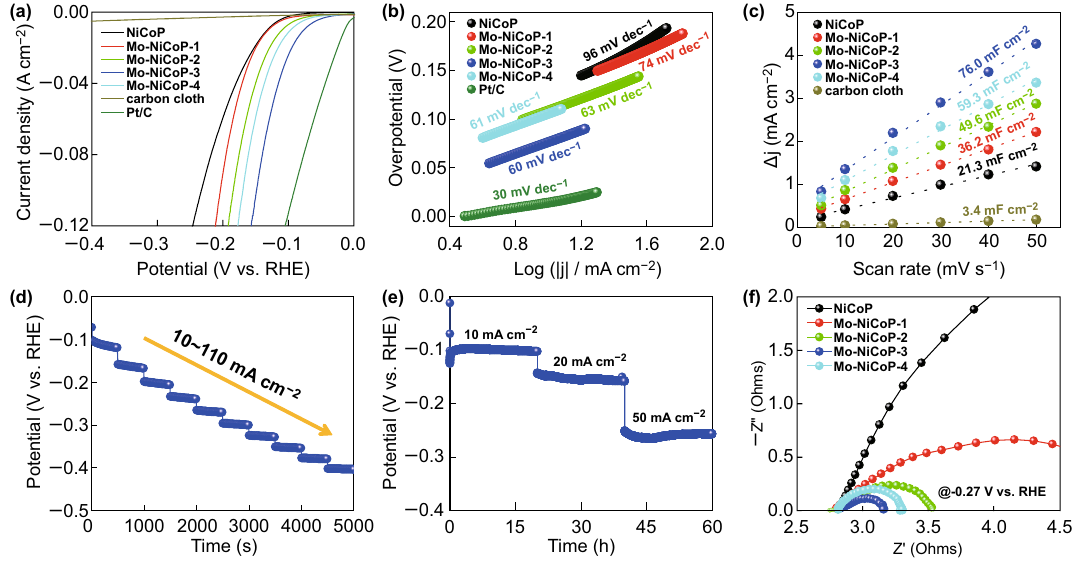
Fig. 2 a Polarization curves, b the corresponding Tafel slope plots, and c the current density against scan rates of obtained samples. d Con- secutive multi-step chronoamperometric tests for Mo–NiCoP-3 (without iR correction). e Chronopotentiometry measurements for Mo–NiCoP-3 (without iR correction). f The Nyquist plots of obtained